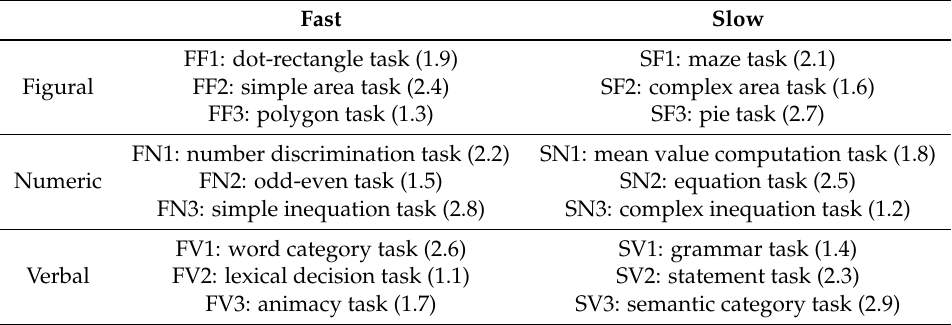
Table 1. Overview of the 3 (domain: figural vs. numeric vs. verbal) × 2 (speed: fast vs. slow) × 3 (number of tasks) = 18 RT